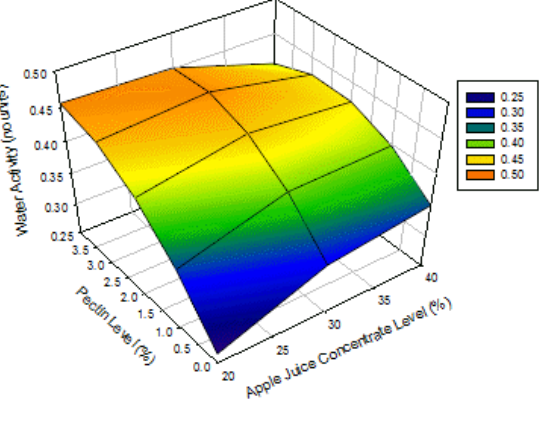
Figure 2. Surface plot for water activity of apple-blackcurrant fruit leather as affected by apple juice concentrate and pectin levels with a blackcurrant concentrate level of 6% (legend shows the range of values on the response